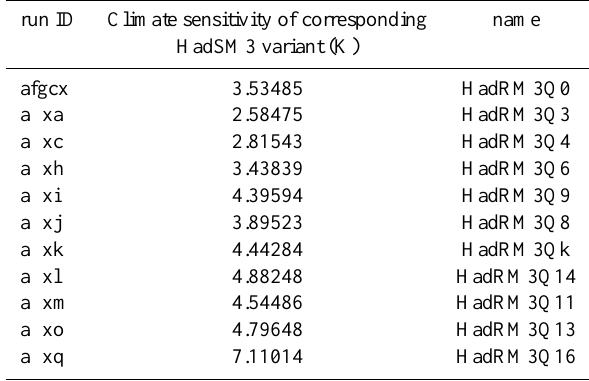
Table 1. HadRM3-PPE run ID, climate sensitivity and model vari- ant name. From http: //